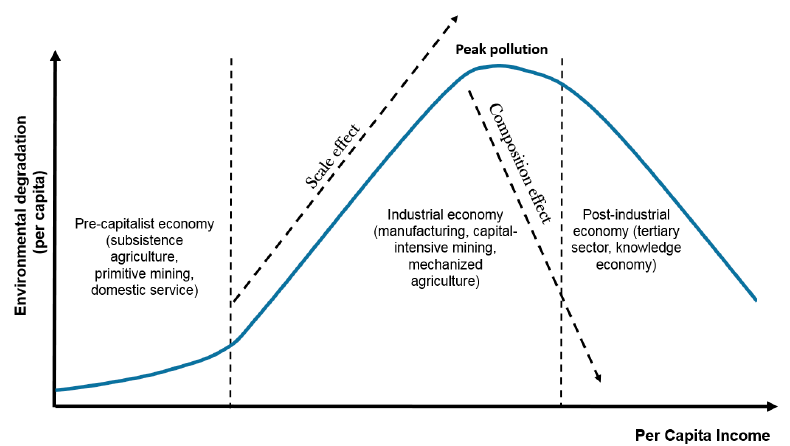
Figure 1. Structural Change and Environmental Degradation. (2013)